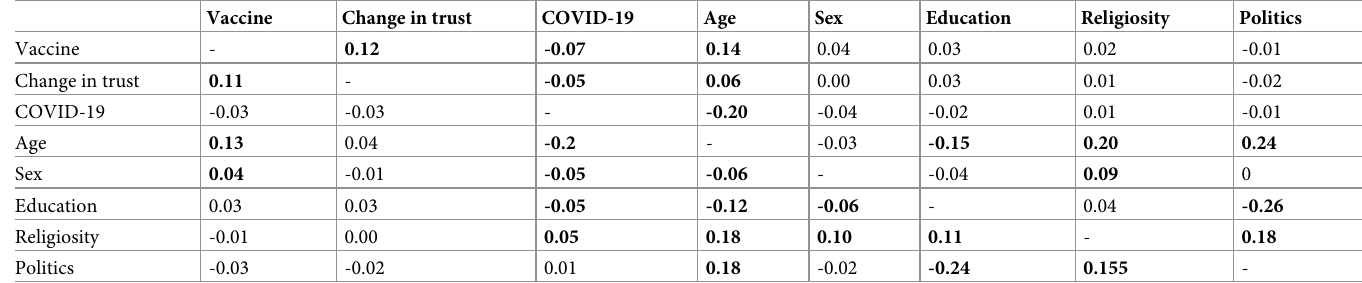
Table 2. Correlation and partial correlation between willingness to take vaccine and change in trust, controlling for having previously contracted COVID-19, age, sex, educational attainment, religiosity and political inclination. Reported figures in the upper panel are raw Spearman Rank correlations. In the lower panel they are partial Spearman’s rho values, controlling for the other variables. Values in bold are significant at P < 0.05, N = 1987. Scoring system as follows: COVID-19 recorded as: never have been infected (0), history of infection, either confirmed by a test, a professional worker or by their own suspicions (1); respondent age was recorded directly as the numerical value; sex was scored with a binomial system (0 = males, 1 = females); educational attainment recorded as degree level (+2), non-degree level (+1) or no qual- ification (0); religiosity recorded as: religious and practising (+2), religious but not practising (+1), non-religious (0). Politics is scored from -1 to +1, more positive imply- ing more right wing based on 10 attitudinal questions